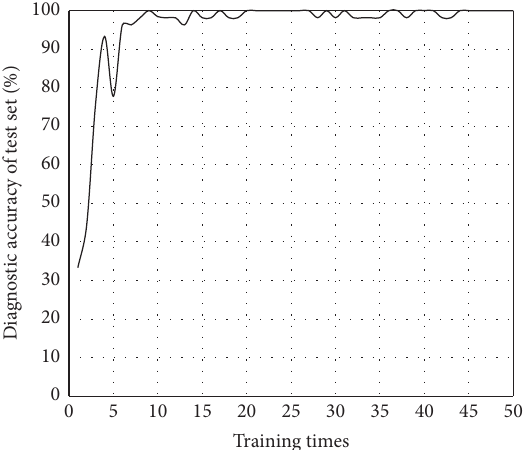
Figure 10: Influence of training time on the accuracy of